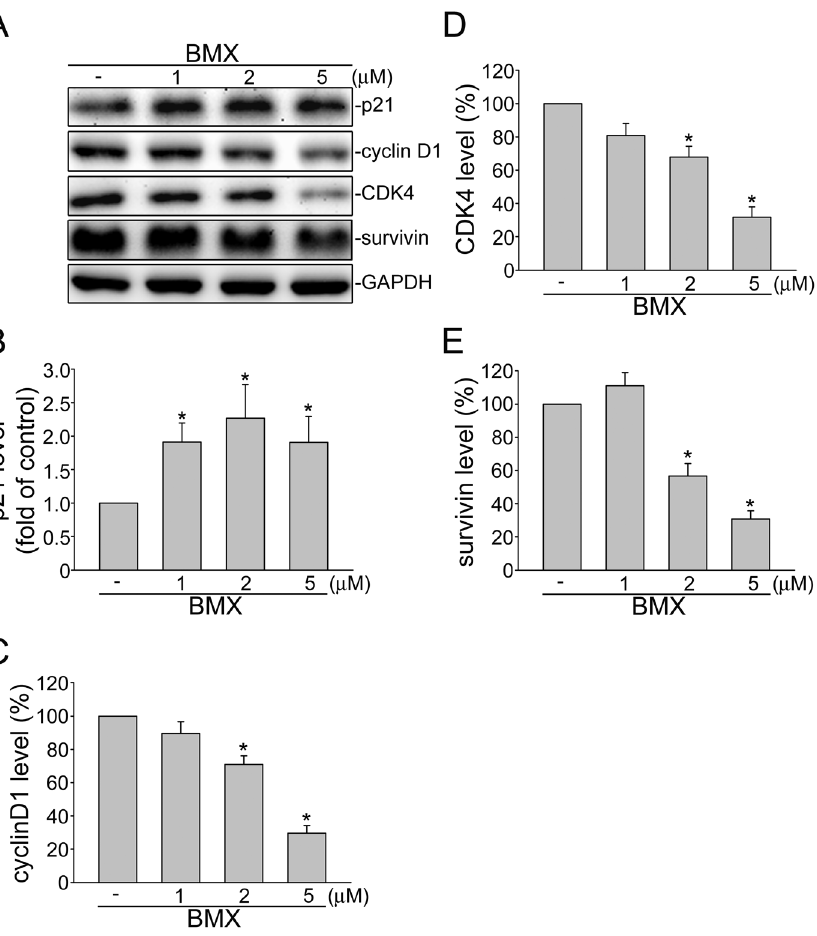
Figure 5. BMX affected the protein levels of p21 cip/Waf1 , cyclinD1, CDK4 and survivin in HUVECs. Cells were treated with indicated concentrations of BMX for 24 h. The protein levels of p21 cip/Waf1 , cyclinD1, CDK4 and survivin were then determined by immunoblotting. Figures shown in (A) are representative of four independent experiments with similar results. The compiled results of p21 cip/Waf1 (B), cyclinD1 (C), CDK4 (D), and survivin (E) levels are shown. Each column represents the mean 6 S.E.M. of four independent experiments. * p , 0.05, compared with the control group